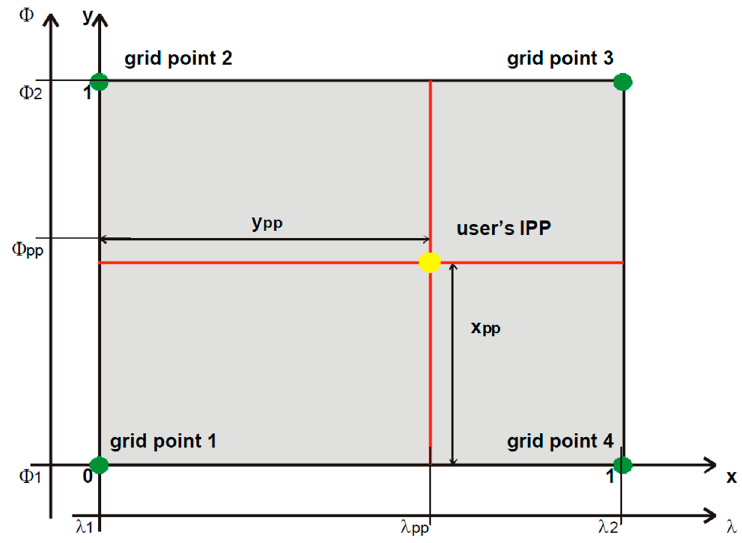
Figure 1. Interpolation concept of the ionospheric vertical delay.